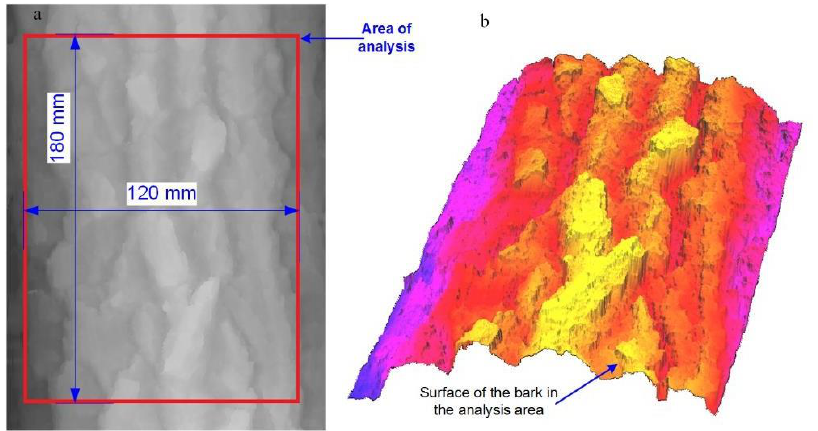
Figure 5. First steps of the analysis of the oak bark surface: ( a ) definition of analysis area and ( b ) the presentation of a three-dimensional surface of bark covered by the target area.